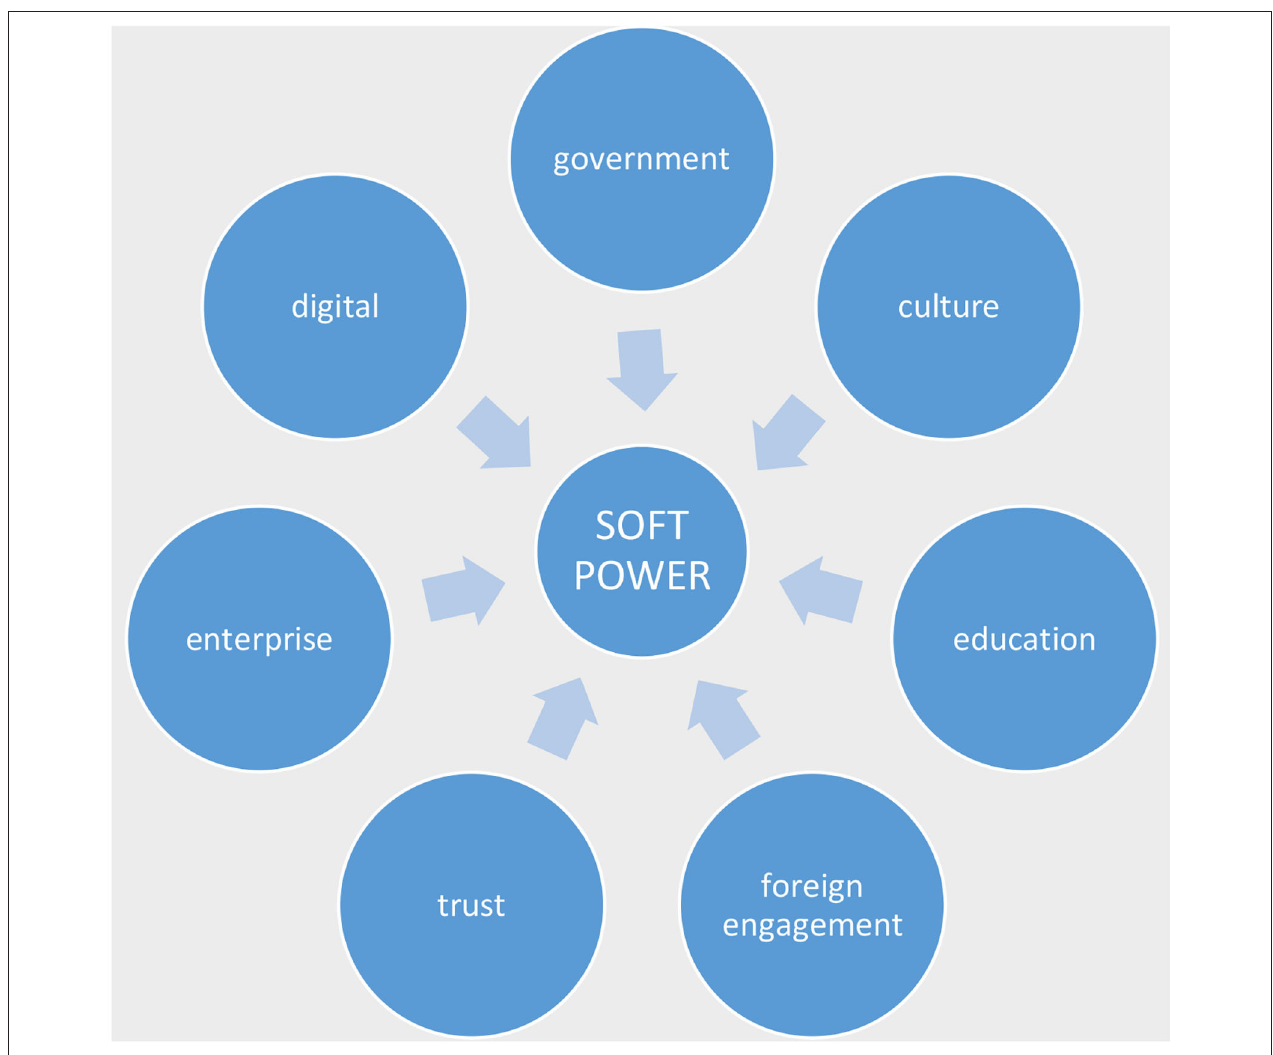
FIGURE 1 | Categories of